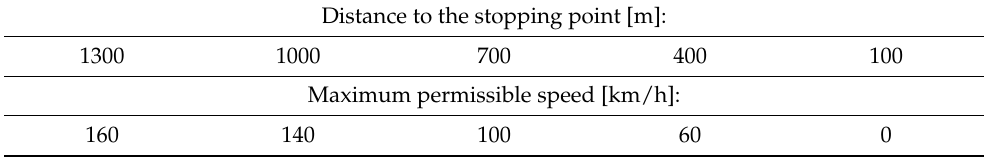
Table 1. The required speed on the braking distance on the lines of PKP Polskie Linie Kolejowe S.A. Distance to the stopping point [m]: